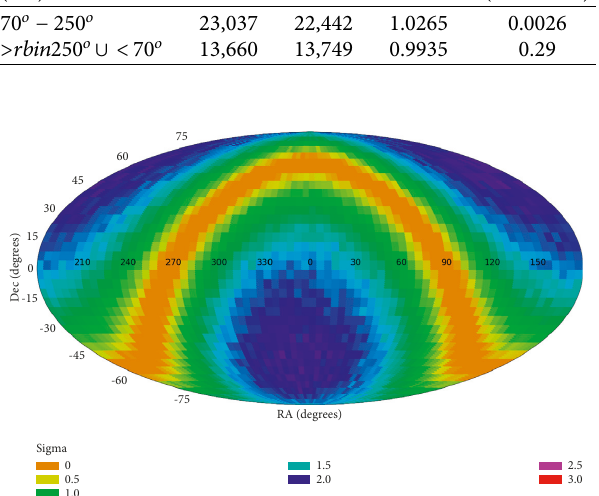
Figure 11: The χ 2 probability of a dipole axis in the spin directions of the galaxies from different ( α , δ ) combinations in the exact same dataset used by